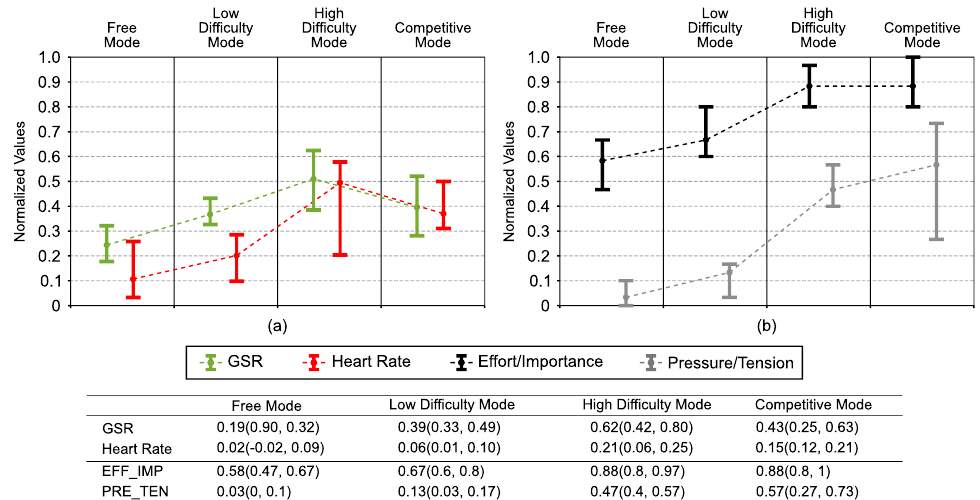
Figure 6. Representation of the results of the parameters related to the user’s affective state. ( a ) Results of the Galvanic Skin Response (GSR) and the heart rate. ( b ) Results of the pressure/tension and effort/importance parameters from Intrinsic Motivation Inventory. All parameters were normalized by the min-max normalization method and are graphically represented in each game mode by the median value and an error bar representing the first and third quartiles. The table collects the non-normalized values of all